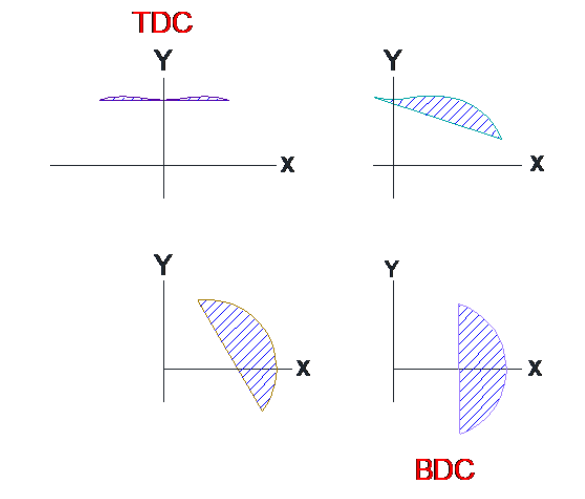
Fig. 4: Wankel engine chamber cross-sectional area at different rotor positions corresponding at every 45 degrees’ rotation of the crankshaft